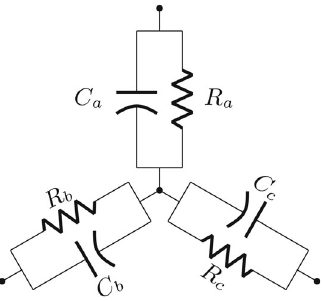
Fig. 4 R − C model of a load